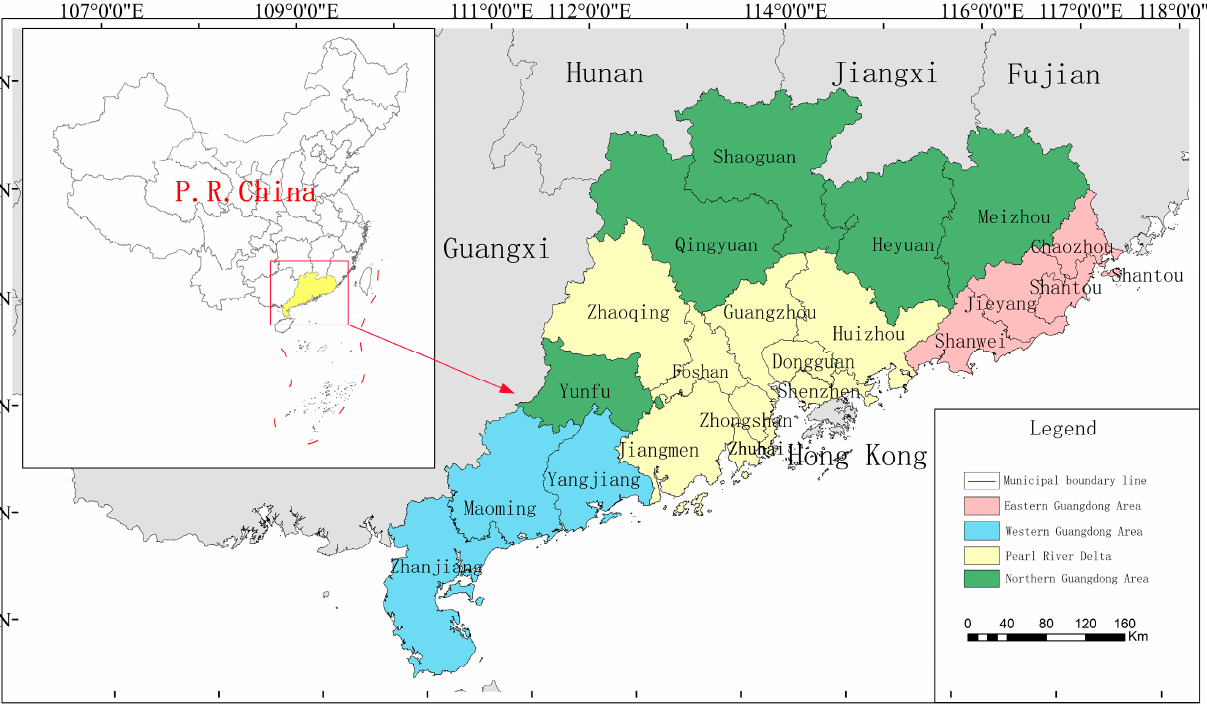
Figure 1. Location Map of Guangdong Province.